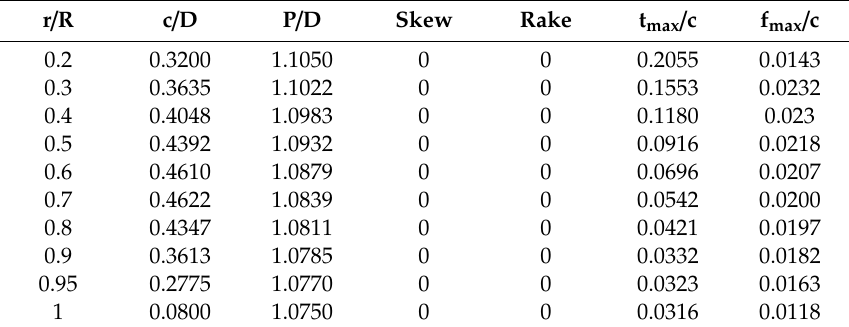
Table 2. Geometry of DTMB 4119 Propeller [20].